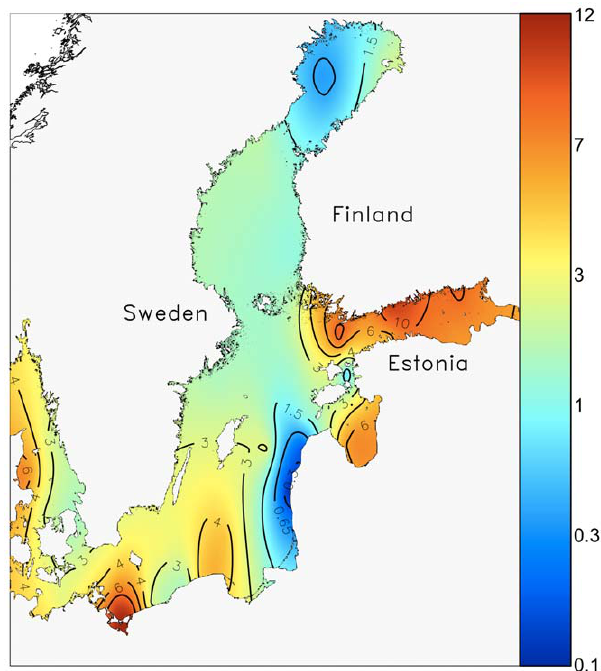
Figure 3. Spatial variability of the spring bloom peak biomass (wet weight, mg L 2 1 ) in the Baltic Sea. High biomass is characteristic to the eutrophied basins (Gulf of Finland, Gulf of Riga), with a biomass . 6 mg L 2 1 . For most of the Baltic Sea, peak biomass of